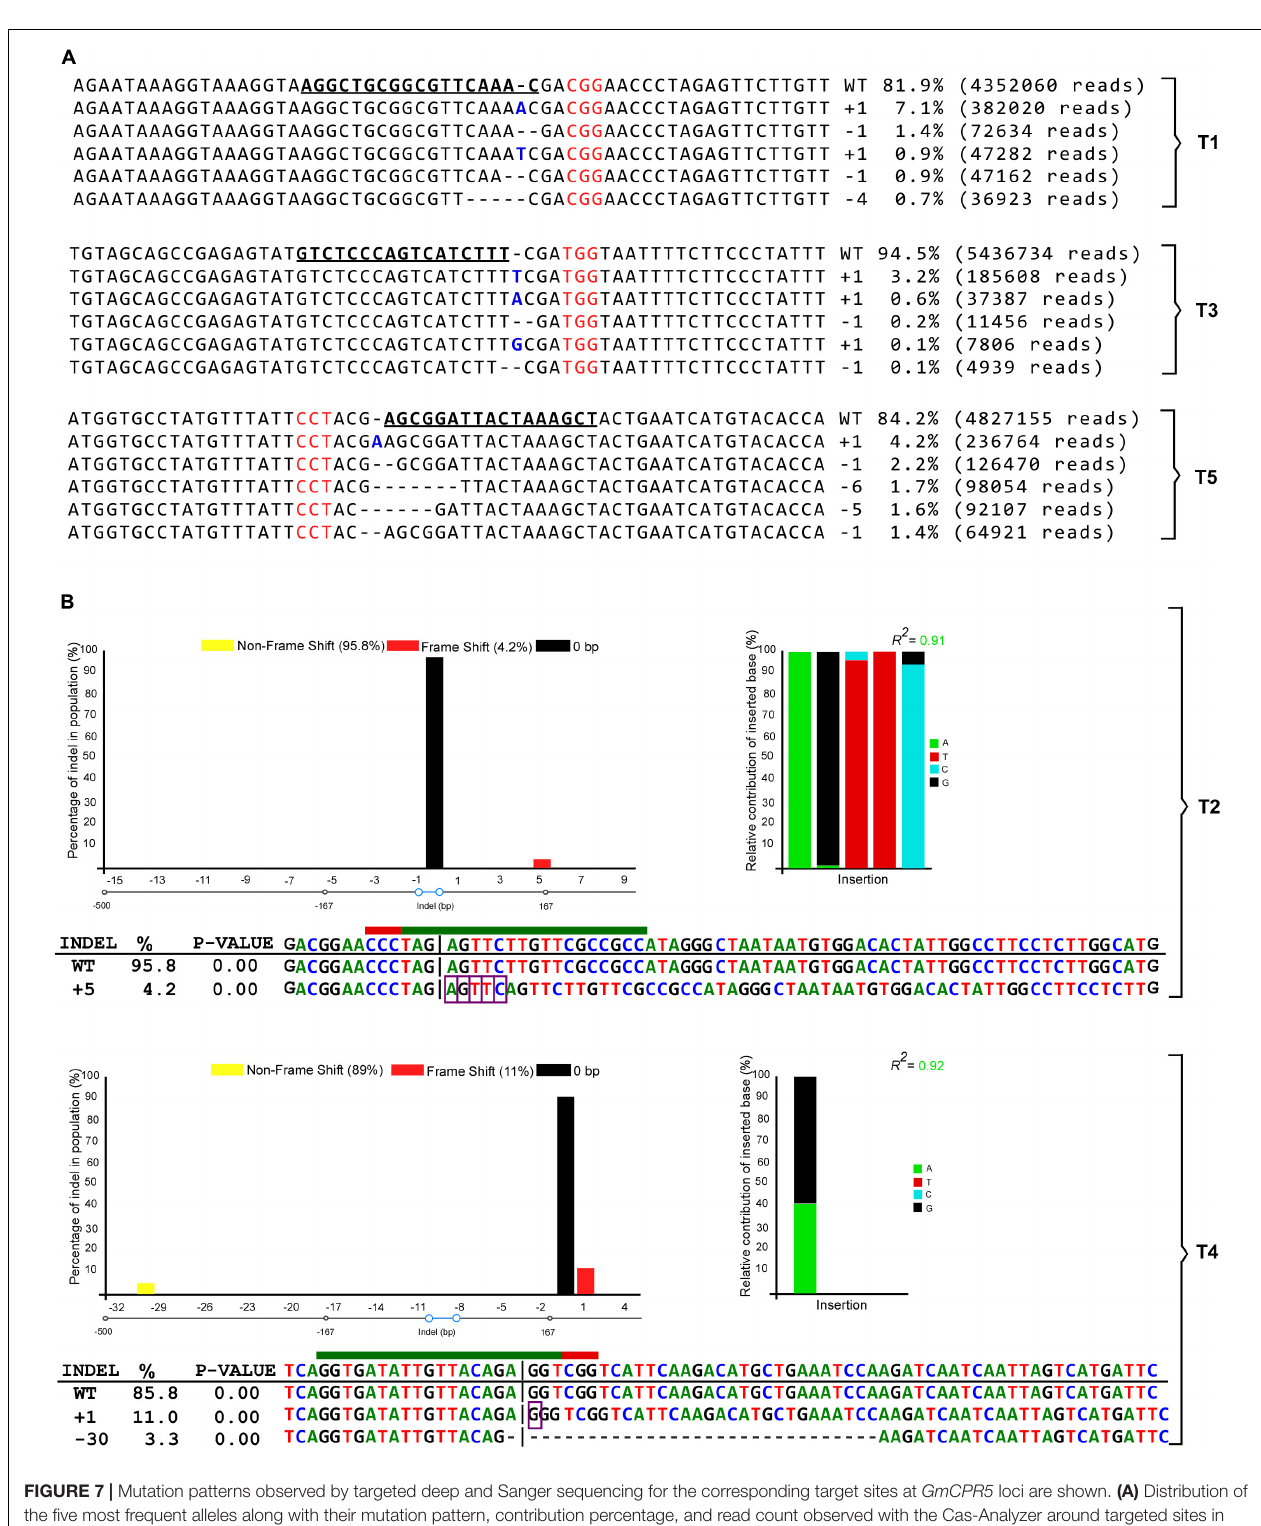
Frontiers in Plant Science |